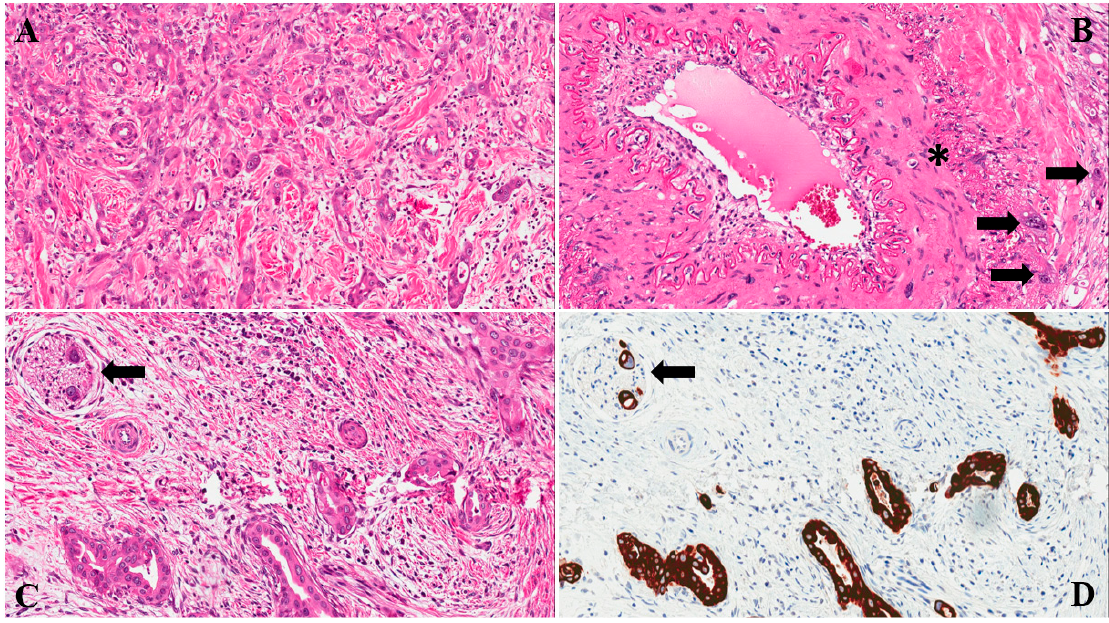
Figure 1. A classical example of PDAC with high-grade tumor budding is shown: note the high number of neoplastic cell clusters formed by less than 5 cells (original magnification: 20×) ( A ); PDAC with high-grade tumor budding can invade the surrounding tissue also with a single cell pattern: few single cancer cells (black arrows) invading the wall of an arteriolar vessel (asterisk, original magnification: 20×) ( B ), and two single PDAC cells of (black arrow) invading a nerve (original magnification: 20×), ( C ): hematoxylin-eosin, ( D ): immunohistochemical staining of the same field of Figure 1C with cytokeratin 8/18 staining.